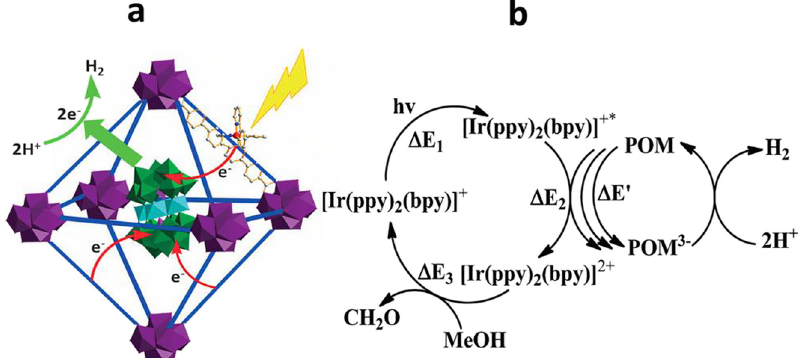
Figure4: (a)SchematicillustrationofPOMOF represents Ni 4 P 2 POM green; Zr, purple; Ir, red, C, gray, the scheme shows photoexcitation of the MOF framework and POM. (b) Proposed catalytic cycle